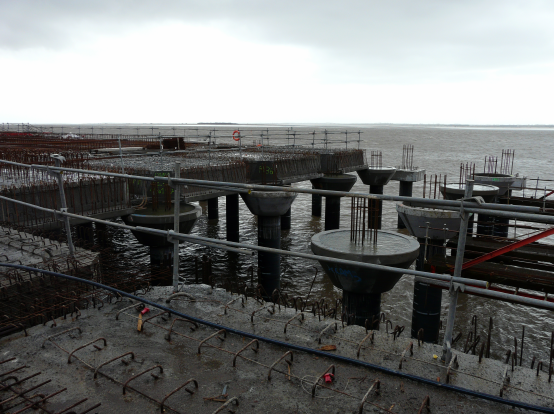
Figure 2. The wharf during construction (precast shell elements and metal